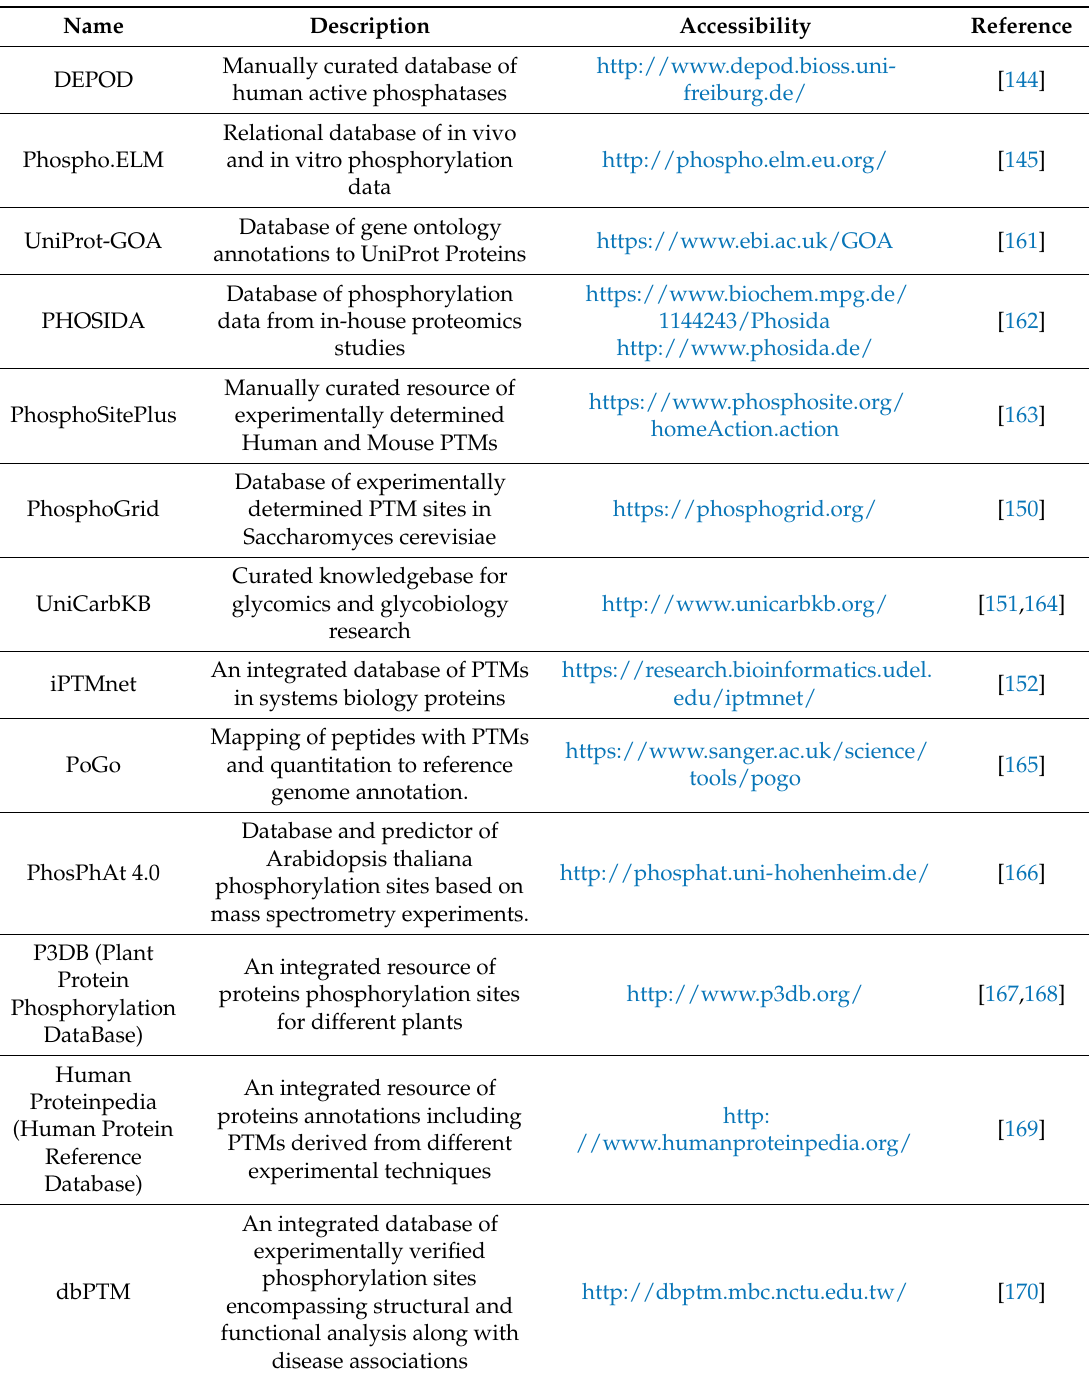
Table 2. PTM annotation databases